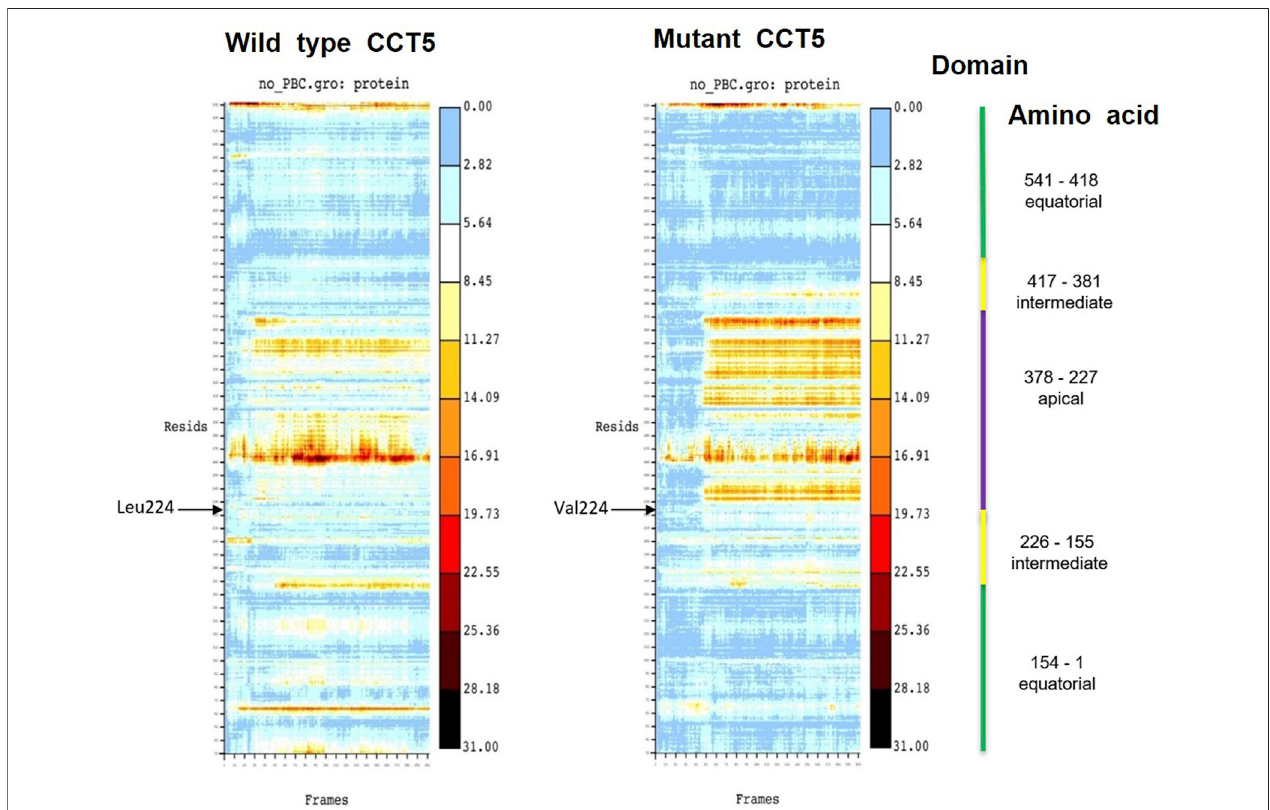
FIGURE 13 | Heat maps of wild type and mutant nucleotide-free CCT5 subunits. In the heat map of the wild type subunit a wider area of heat is observed in the region between the amino acids (Resids) 260 and 270 (at 11.27 Å) and between amino acids 230 and 250 (at 16.91 Å). These two regions are within the apical domain (indicated by a violet vertical line on far the right). In the mutant subunit a wider heat area is observed in a region between amino acids 230 and 370 (between 19.73 and 16.91 Å), whichisintheintermediate domain, beginning veryclosetoposition224intheN-terminalsegmentoftheintermediatedomain, where thepointmutation occurs (indicated by the black arrow Val224), and it spans the entire apical